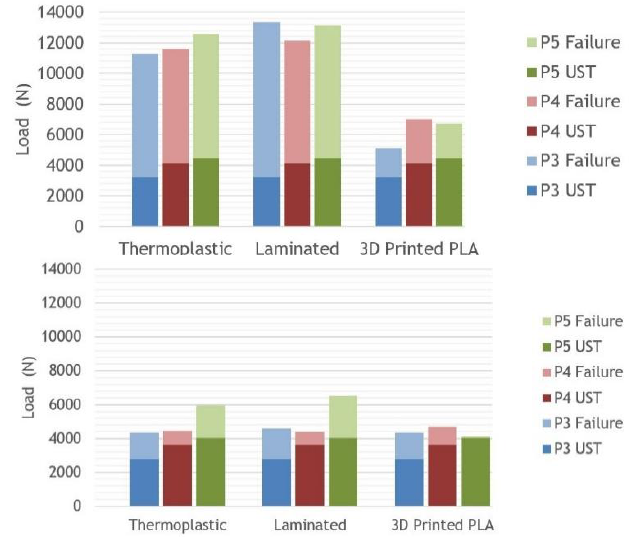
FIGURE 4. A (Top): For cushion sockets at Condition I (early stance phase), all set ups failed above the ultimate strength test (UST) values specified in ISO 10328 ; B (Bottom) : For cushion sockets at Condition II (late stance phase), all set ups failed above the ultimate strength test values specified in ISO 10328. In 2/3 cases, the modular components were the cause of